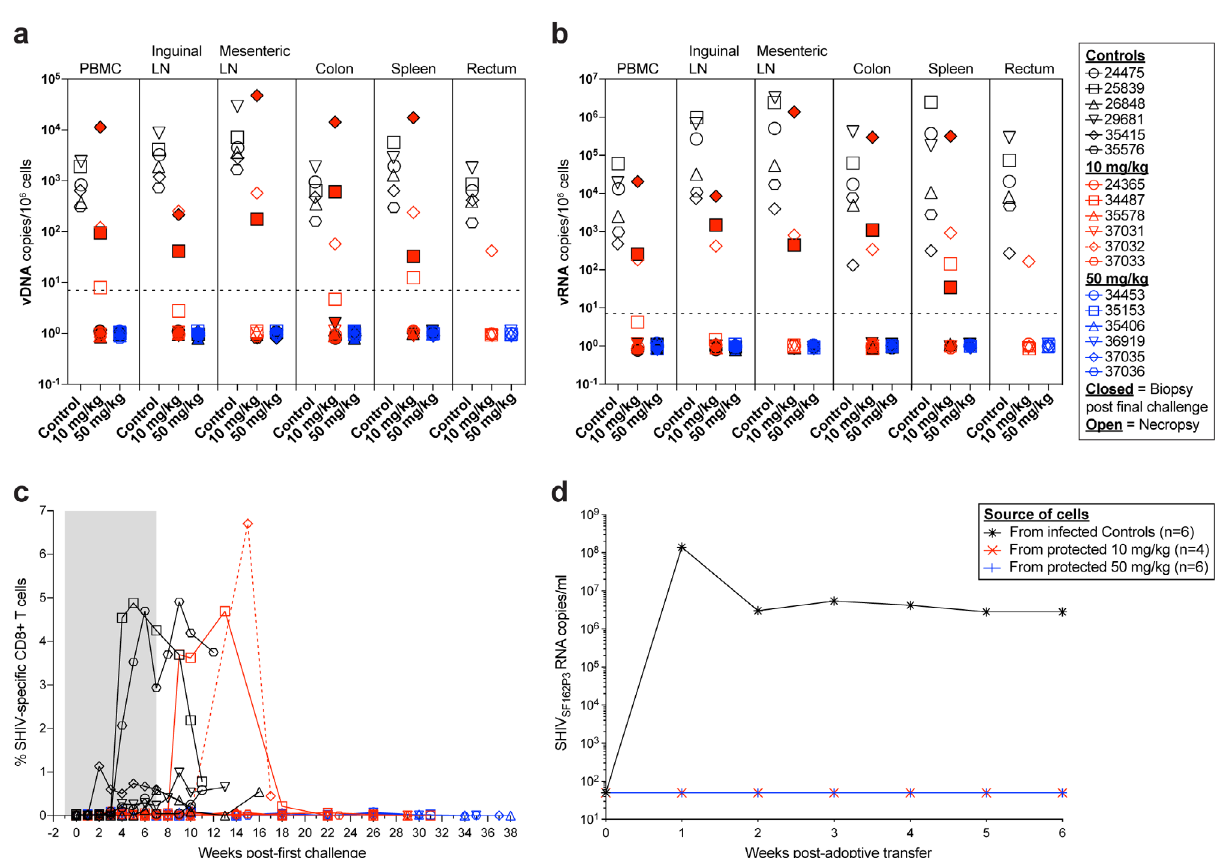
Fig. 4 Validation of protected Leronlimab-treated rhesus macaques. Showing untreated control animals (black), 10 mg/kg treated animals (red), and 50 mg/kg treated animals (blue). a , b Cell-associated SHIV SF162P3 DNA (a) and RNA (b) viral loads after fi nal challenge (closed symbols, biopsies at study week 8 or 9) and at necropsy (open symbols). Horizontal dashed lines in a and b denote assay limit of quanti fi cation of 7 copies/10 6 cells. c Longitudinal SHIV-speci fi c CD8 + T cell responses as determined by intracellular cytokine staining. Positive percentage of responses were determined by Boolean gating to CD8 + T cells that were CD69 + /TFN- α + and/or CD69 + /IFN- γ + . Gray box denotes the Leronlimab treatment phase for Leronlimab-treated macaques. d Longitudinal SHIV SF162P3 plasma viral loads in adoptive transfer recipients infused with cells harvested from macaques of each group upon euthanasia (one recipient per group). Each adoptive transfer recipient received a combined infusion of cells from six infected control macaques, from four aviremic 10 mg/kg treated macaques, or from six aviremic 50 mg/kg treated macaques (see Supplementary Table 3 for breakdown of infused cells). Horizontal dashed line denotes assay limit of quanti fi cation (50 copies/mL). Group colors and individual animal symbols are consistent throughout the manuscript. Source data are provided as a Source Data fi and all six group 3 animals were pooled by group and infused at fi nal cell counts of 7.8 × 10 8 , 6.9 × 10 8 , and 9.7 × 10 8 cells, respec- tively (Supplementary Table 3). Transfer of SHIV SF162P3 infection occurred with the infusion of cells from infected control animals, but not isolated cells from protected animals in group 2 or 3 (Fig. 4d). Together, these results indicate that Leronlimab mediated sterile protection against mucosal acquisition of SHIV SF162P3 in the aviremic animals.